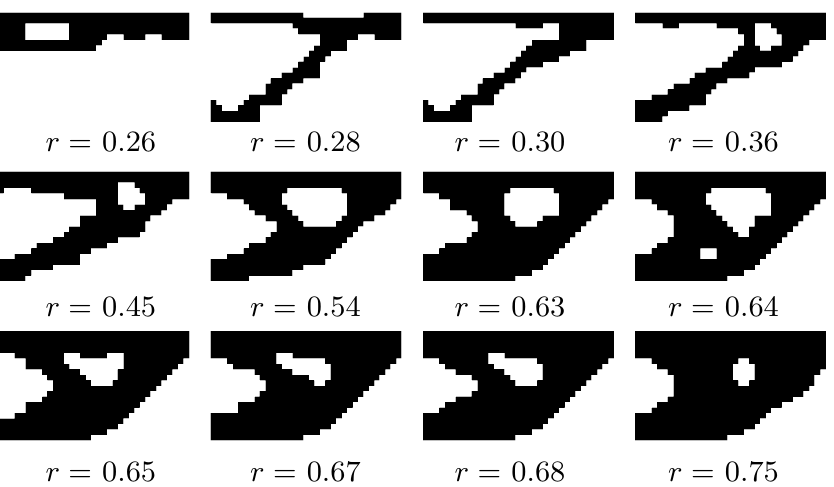
Figure 11. Twelve optimized solutions to the design problem in Figure 7 with respect to the displace- ment in A and the relative volume r . The relative volume is constricted to r ≤ 0.75 and the maximum stress is restricted to 0.003 E .